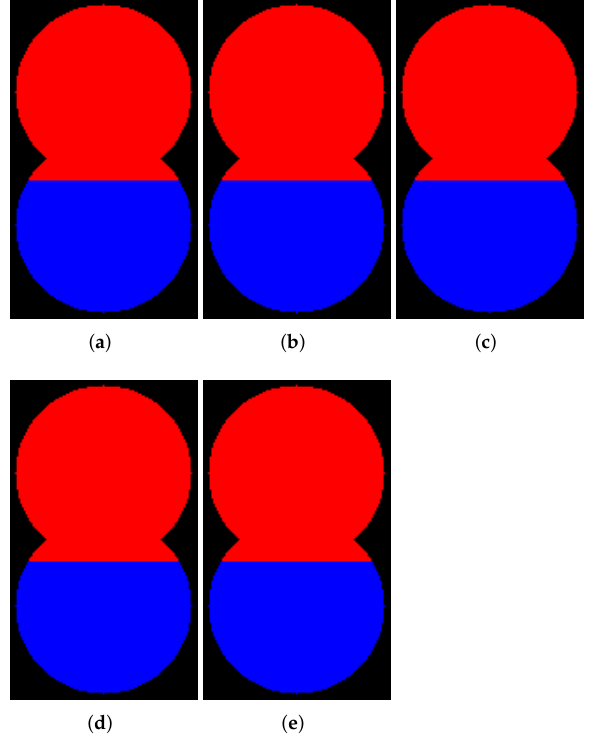
Figure 7. Results of segmentation via watershed without WL (4-connectivity): ( a ) ImageJ; ( b ) ITK; ( c ) Mahotas; ( d ) Scikit-image; ( e )